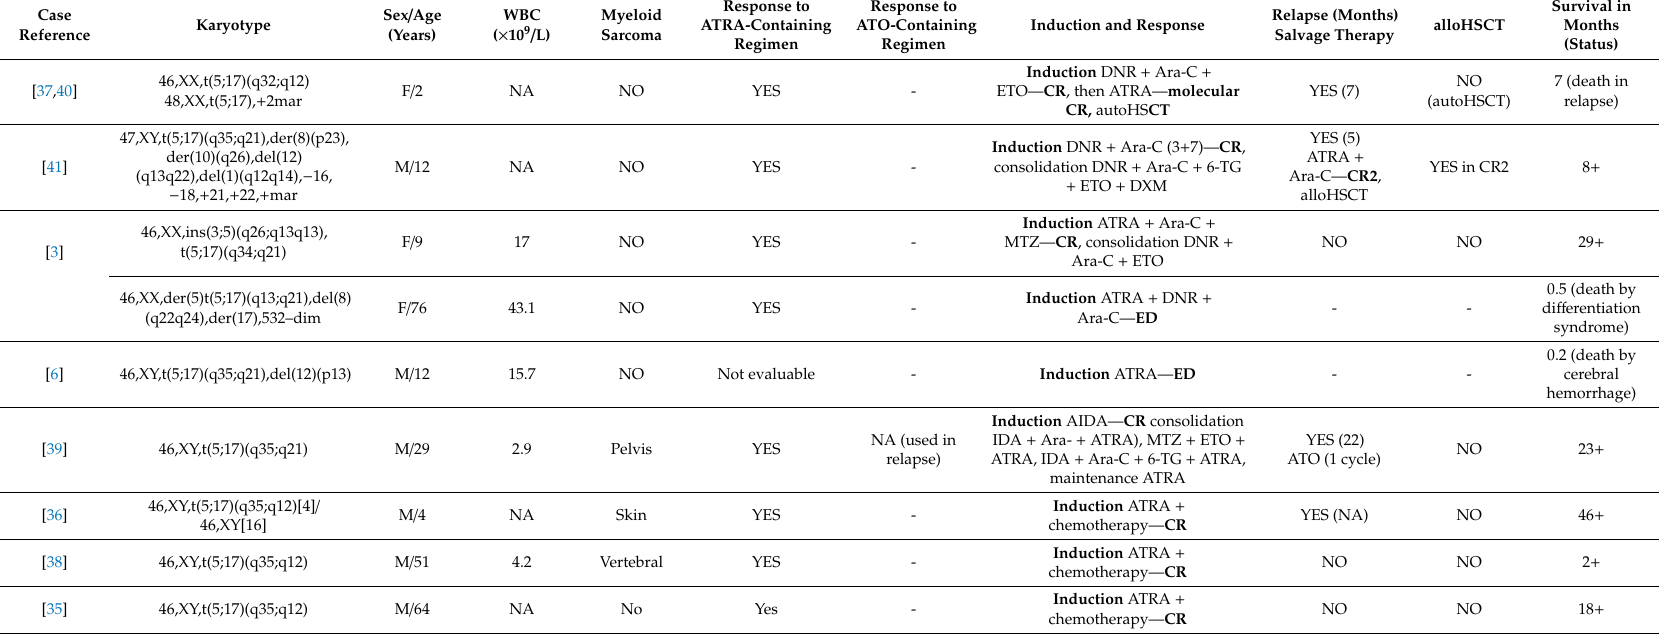
Table 3. Characteristics, treatment, and outcomes of 9 NPM1-RARa APL patients reported in the